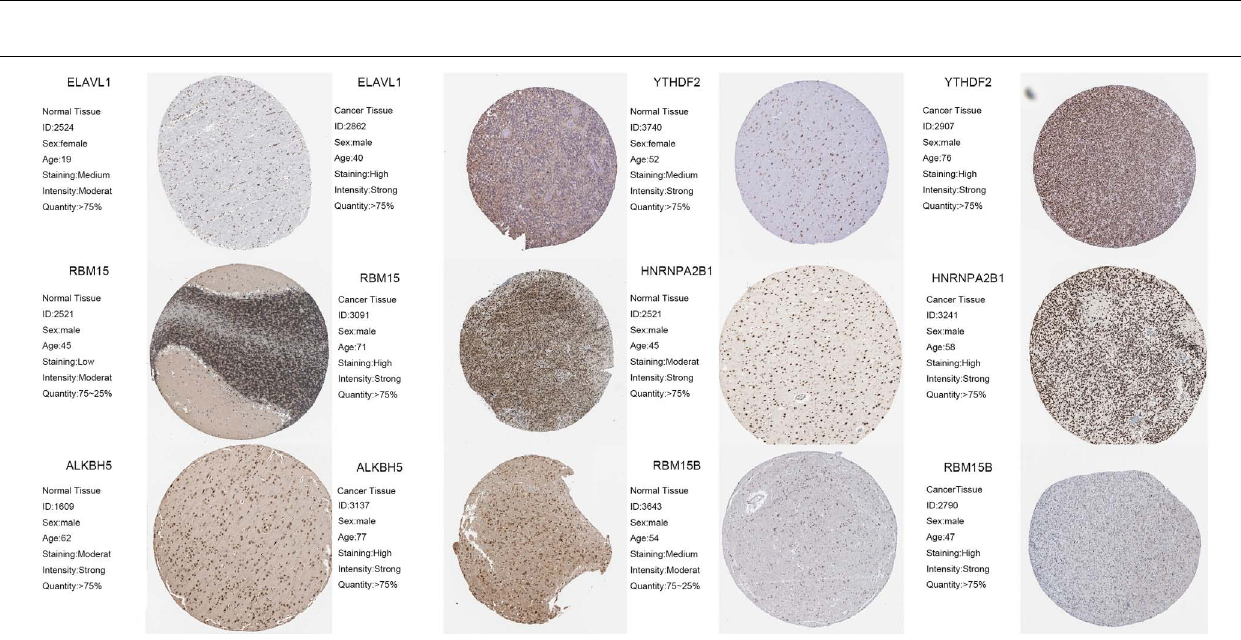
Frontiers in Cell and Developmental Biology |